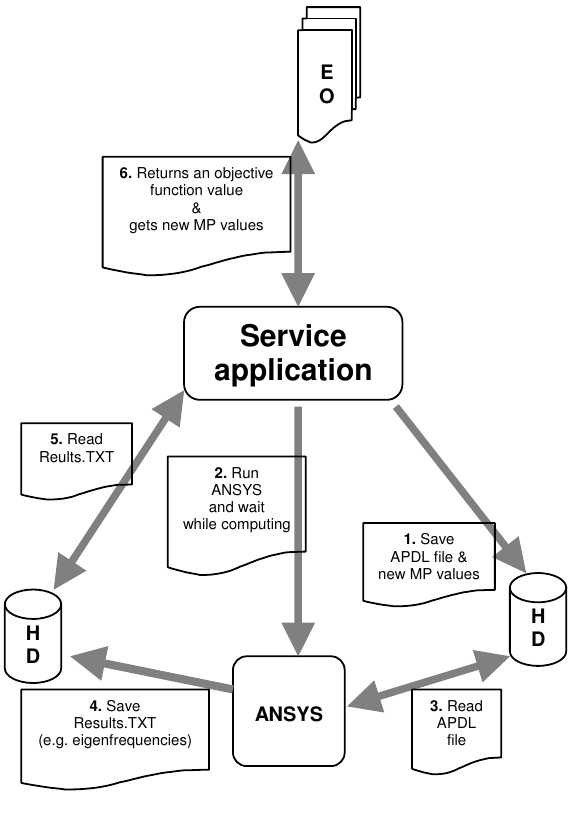
Fig 1. Detailed optimisation